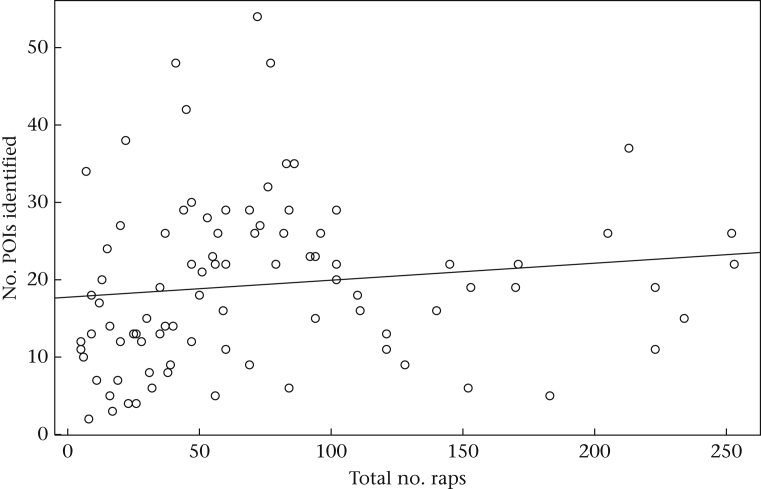
Correlation between number of points of impact (POIs) identified and the total number of raps performed.